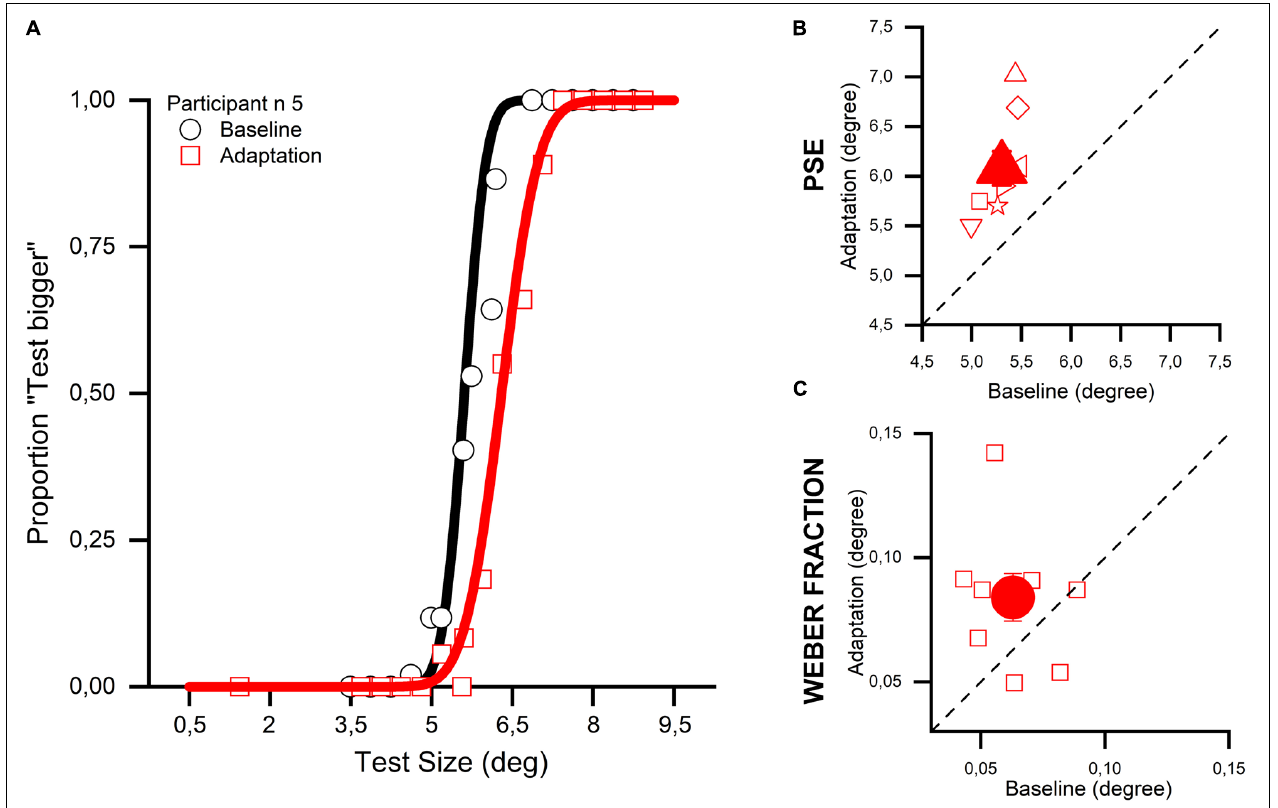
FIGURE 2 | Size adaptation effect in the absence of attentional manipulation. (A) The psychometric function of one participant (number 5) is shown for the baseline (in black) and the adaptation condition (in red). Adaptation to a 10 ◦ stimulus with a reference of 5 ◦ produced a rightward shift of the curve. This shift indicates that the adaptation produced a reduction of the perceived size of the test stimulus, because the adaptive algorithm used during the discrimination task needed to increase the size of the test stimulus so that it was perceived identical to the reference stimulus. (B) The big filled red triangle depicts the average PSE for all the participants, while the small empty symbols show the data for the single participant. On the x-axis the PSEs for the baseline condition are plotted, while on the y-axis the PSEs for the adaptation condition are shown. (C) The big filled red circle shows the average WF for all the participants, while the small empty symbols correspond to the data for the individual participants. On the x-axis the WFs for the baseline condition are plotted, while on the y-axis the WFs for the adaptation condition are